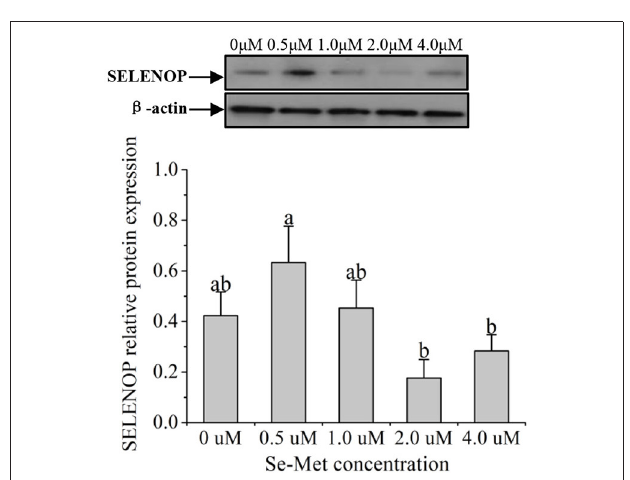
FIGURE 7 | Effects of selenomethionine (Se-Met) supplementation on TXNRD1 protein expression in porcine mammary epithelial cells (pMECs). The cells were incubated for 48h with different concentrations of Se-Met (0, 0.5, 1, 2, and 4 µ M), and then collected for the determination of protein expression. The data are expressed as the mean ± SEM ( n = 3). The β -actin blot was reused as shown in Figure 6 . Different superscript letters indicate a significant difference ( p <